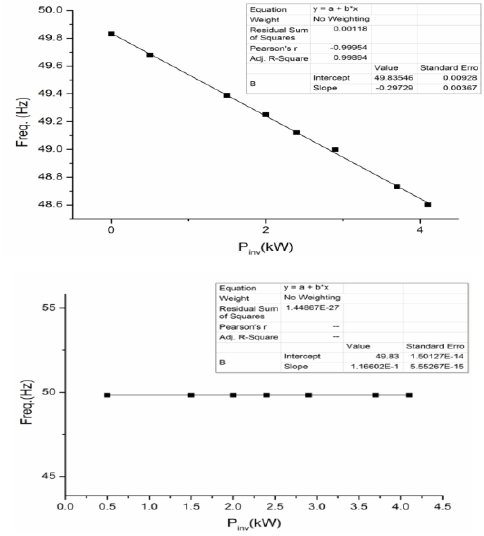
Figure 11. The f-P droop curve for asymmetric load variation with phase A (master inverter) and phases B, C (slave inverters).